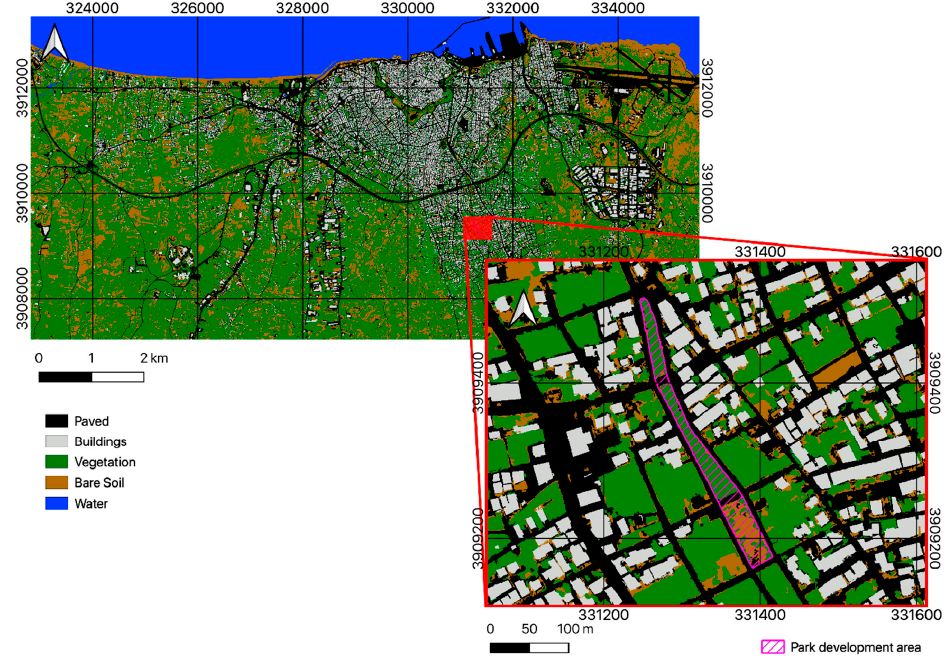
Figure 7. Surface cover map of Heraklion and the area of the park under the 5-class classification scheme (classification accuracy: 92.6%).